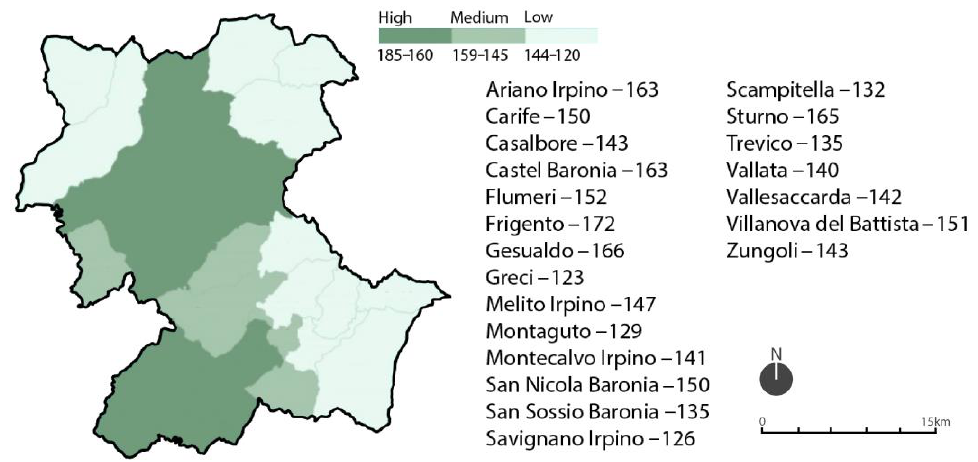
Figure 5. Summary map of the resilience of the Ufita focus area © RI.P.R.O.VA.RE Project.